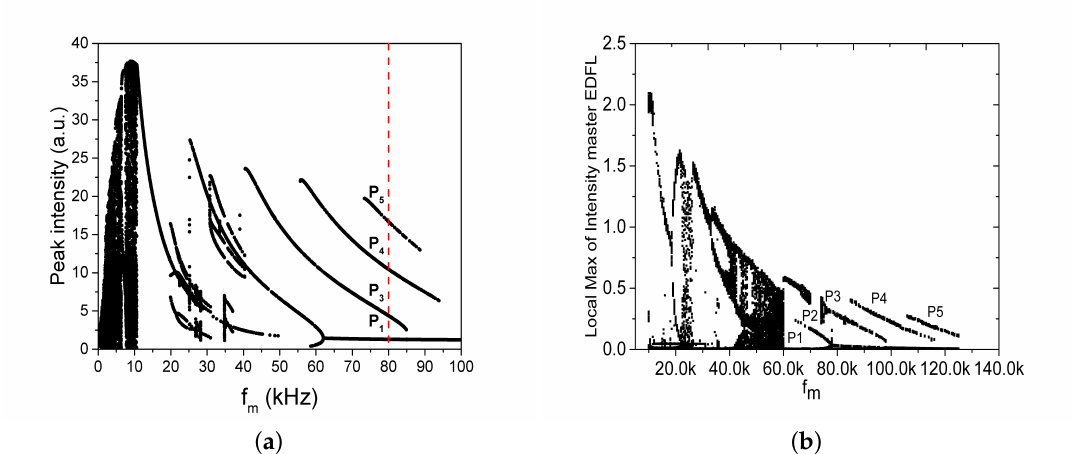
Figure 1. EDFL Bifurcation diagram. ( a ) Numerically calculated, ( b ) experimentally determined.